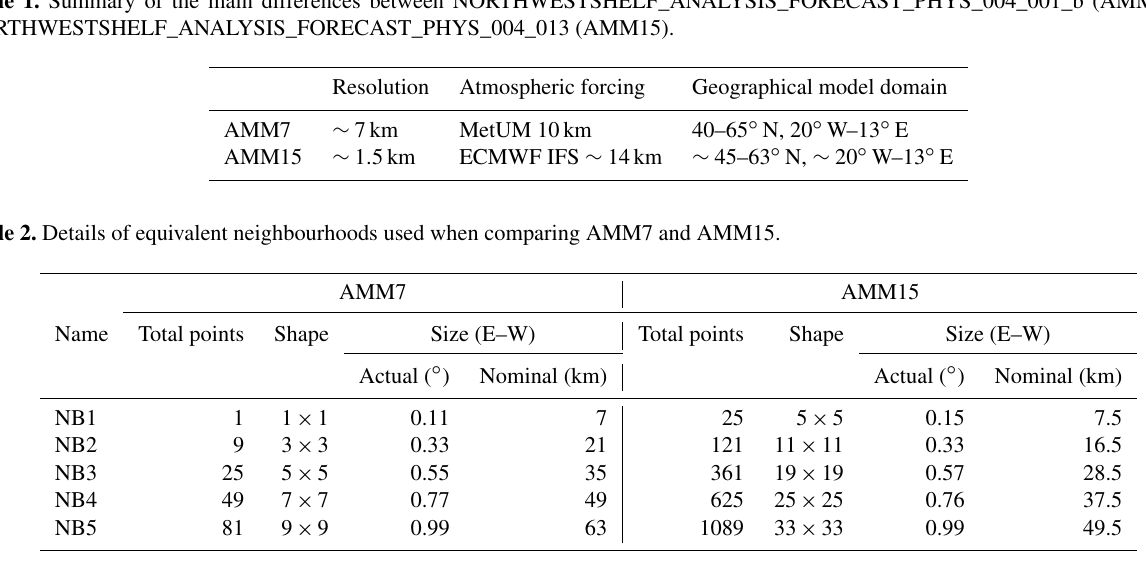
Table 1. Summary of the main differences between NORTHWESTSHELF_ANALYSIS_FORECAST_PHYS_004_001_b (AMM7) and NORTHWESTSHELF_ANALYSIS_FORECAST_PHYS_004_013 (AMM15).